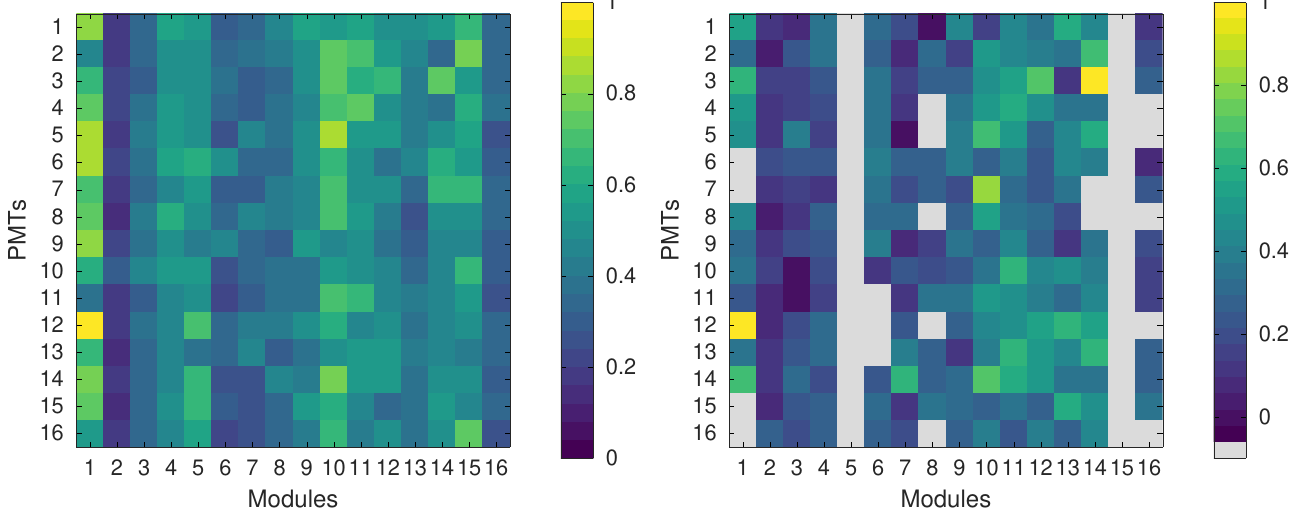
Figure 1. Relative sensitivities of channels of the TUS photodetector. Left : pre-flight measurements (adapted from [32]). Right : estimations obtained from the data. Dead channels are shown in